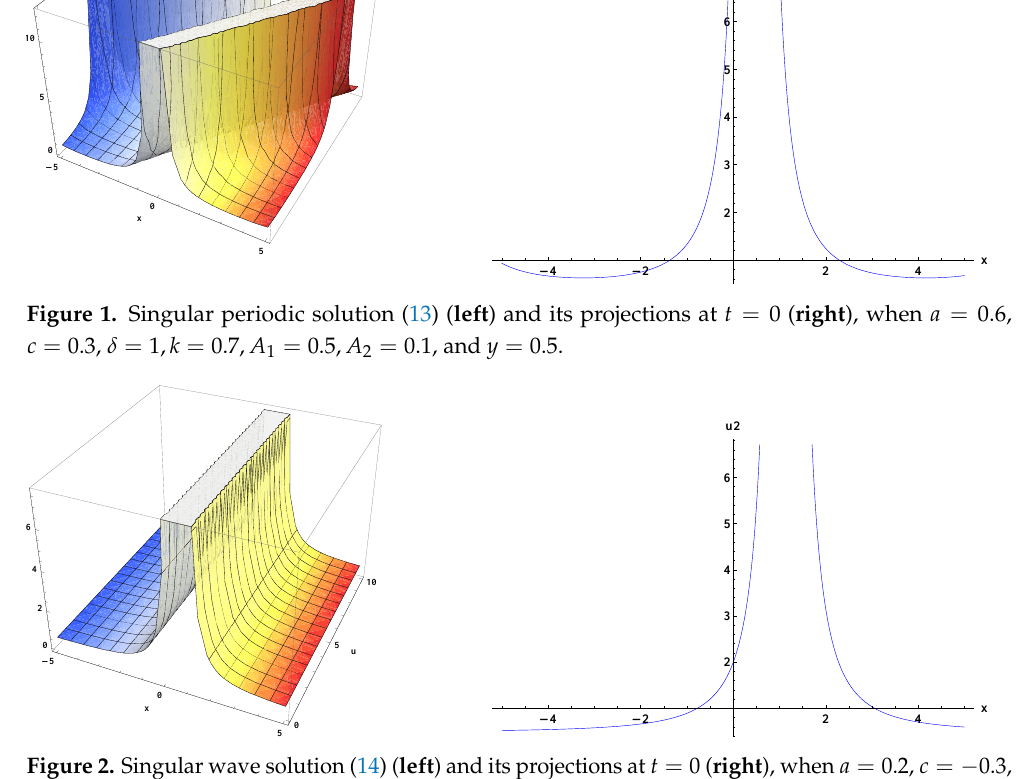
Figure 2. Singular wave solution (14) ( left ) and its projections at t = 0 ( right ), when a = 0.2, c = δ = 1, k = 0.3, A 1 = 0.4, A 2 = 0.7, and y = 0.5.